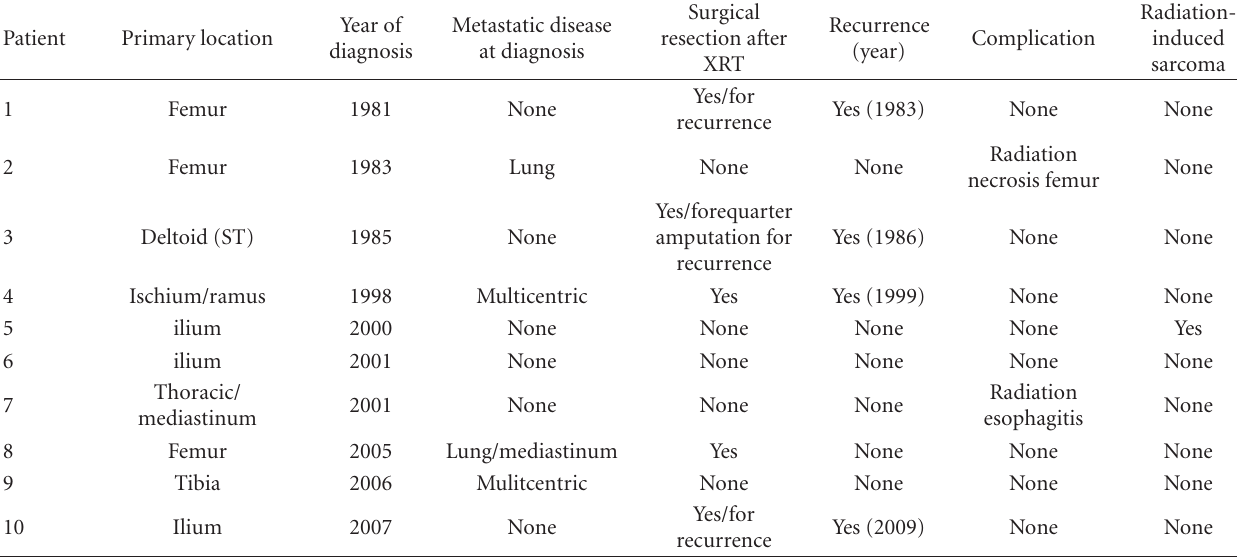
ST: soft tissue EWS.